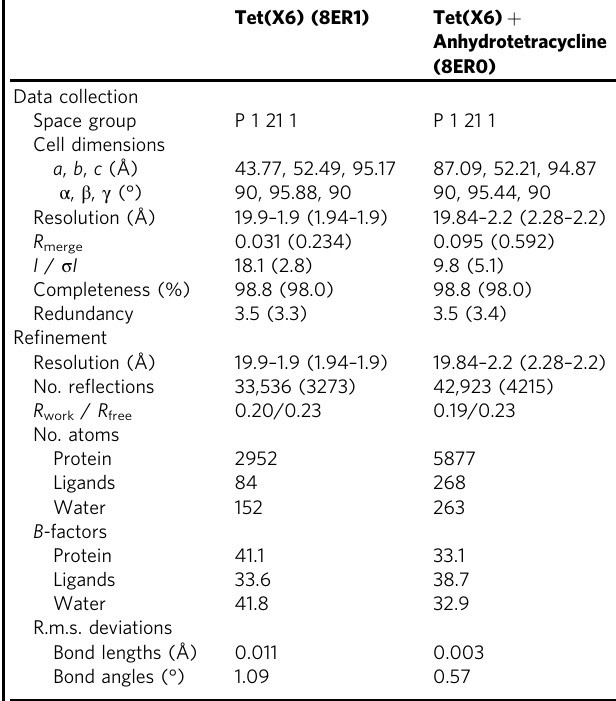
Each structure was solved from a single crystal. Values in parentheses are for highest- resolution